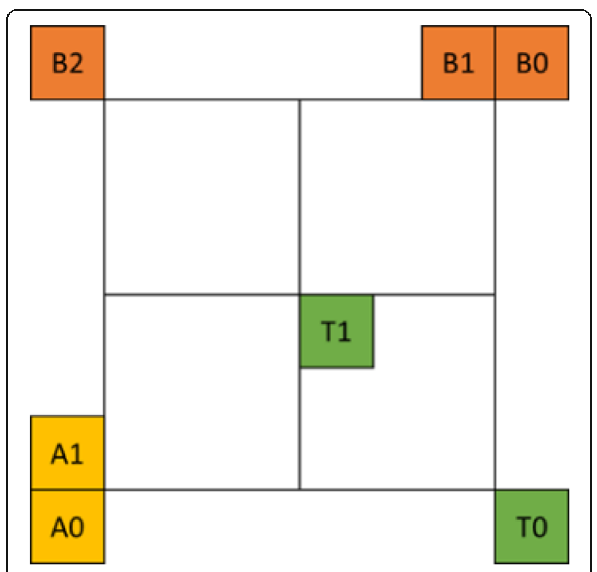
Fig. 4 Reference locations of Merge and AMVP candidates